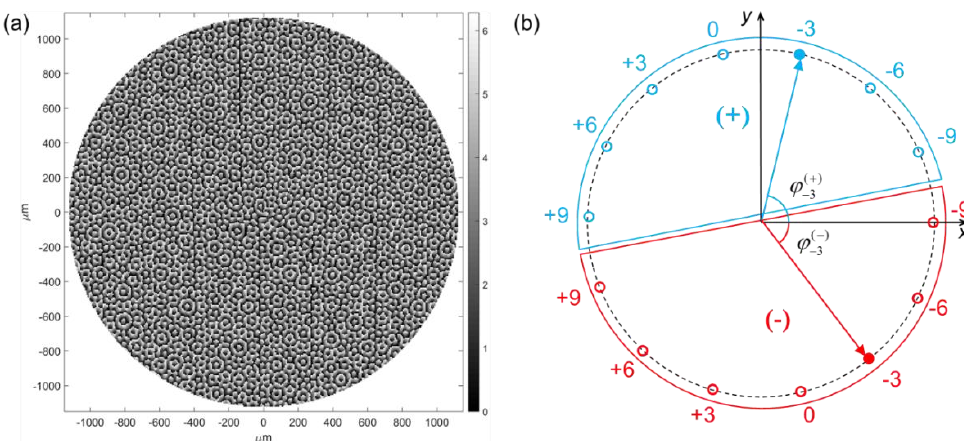
Figure 4. ( a ) Numerical phase pattern for the demultiplexing of optical beams with OAM in the set { − 9, − 6, − 3, 0, + 3, + 6, + 9} on a semicircular configuration. Pixel size: 6.250 µ m × 6.250 µ m. 16 phase levels. Radius length: 180 pixels. ( b ) Far-field channel scheme for the given OAM set and circular polarization states. Right-handed (in blue) and left-handed (in red) circularly-polarized OAM beams are detected in far field on two distinct and complementary semicircles.